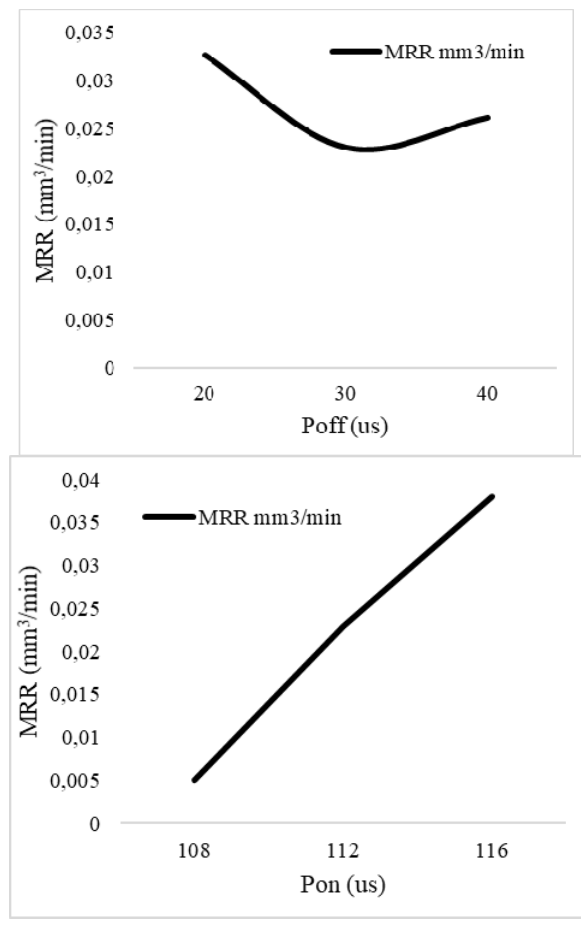
Figure 5. Variation of MRR with variable process